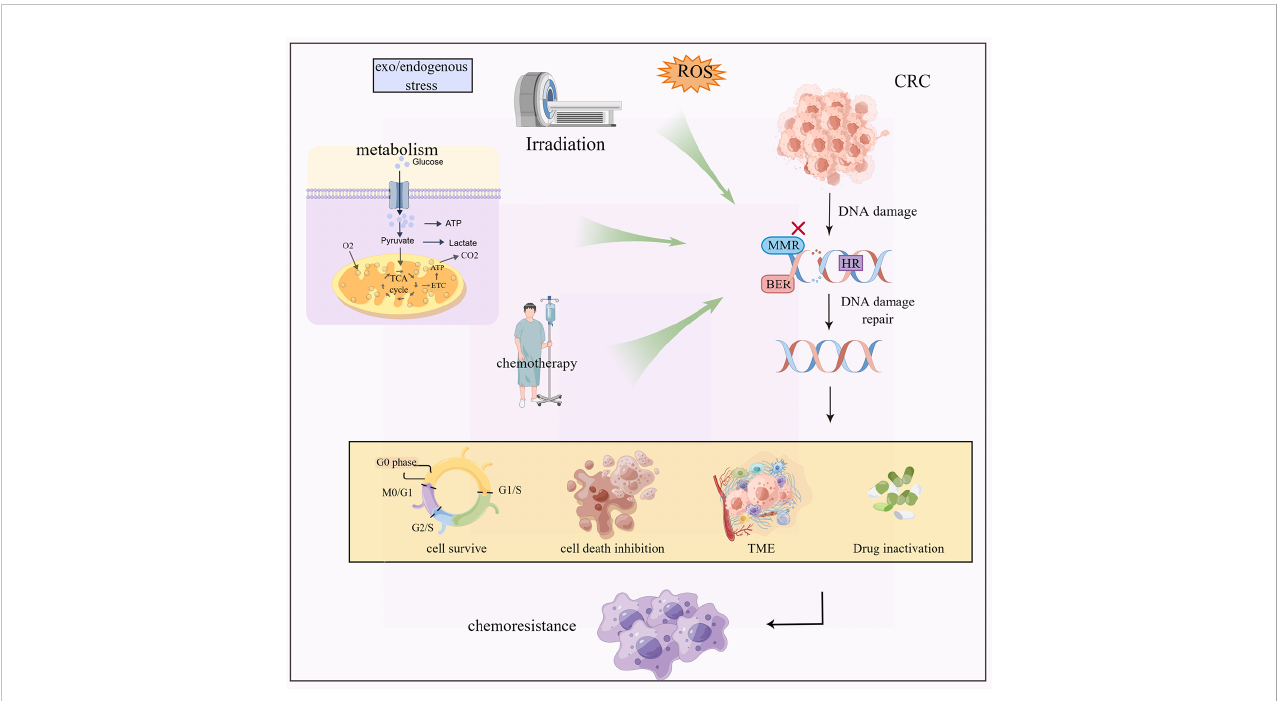
FIGURE 2 Exogenous and endogenous stresses such as radiotherapy and chemotherapy, metabolic reprogramming and ROS cause DNA damage and repair inhibition of CRC cells, which cause chemoresistance by regulating cell death, tumor microenvironment change and drug